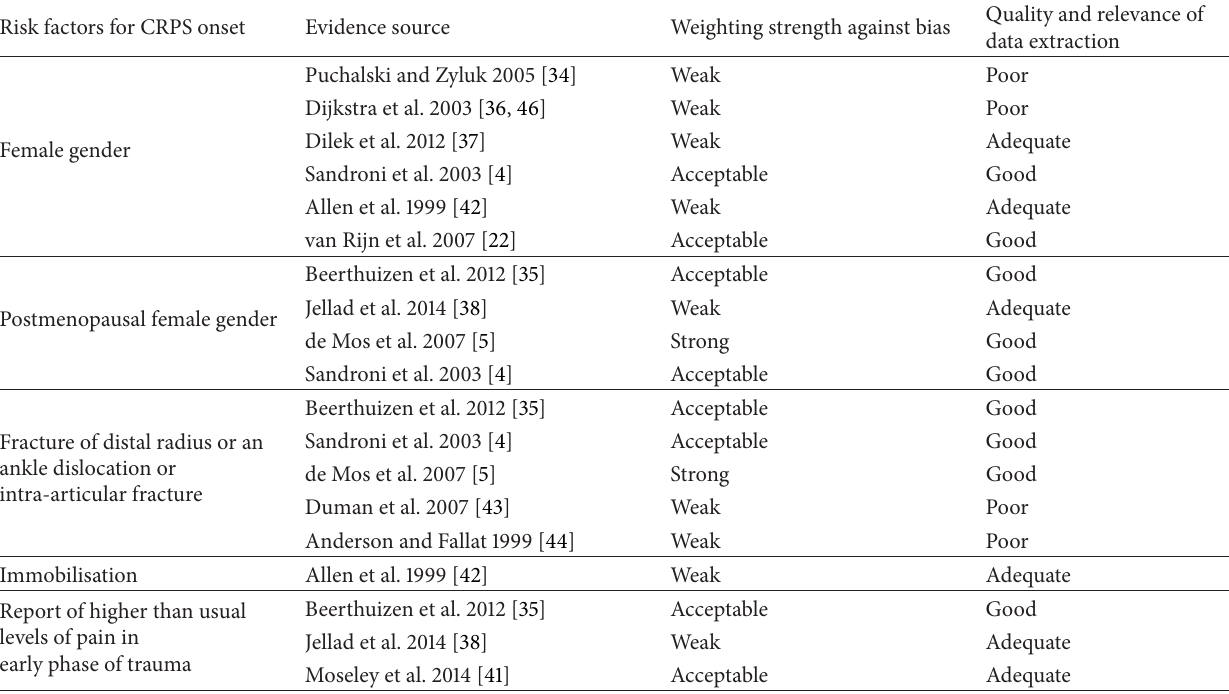
Table 10: Results summary showing possible risk factors for the onset of CRPS 1 with weighting bias strength and quality and relevance. Risk factors for CRPS